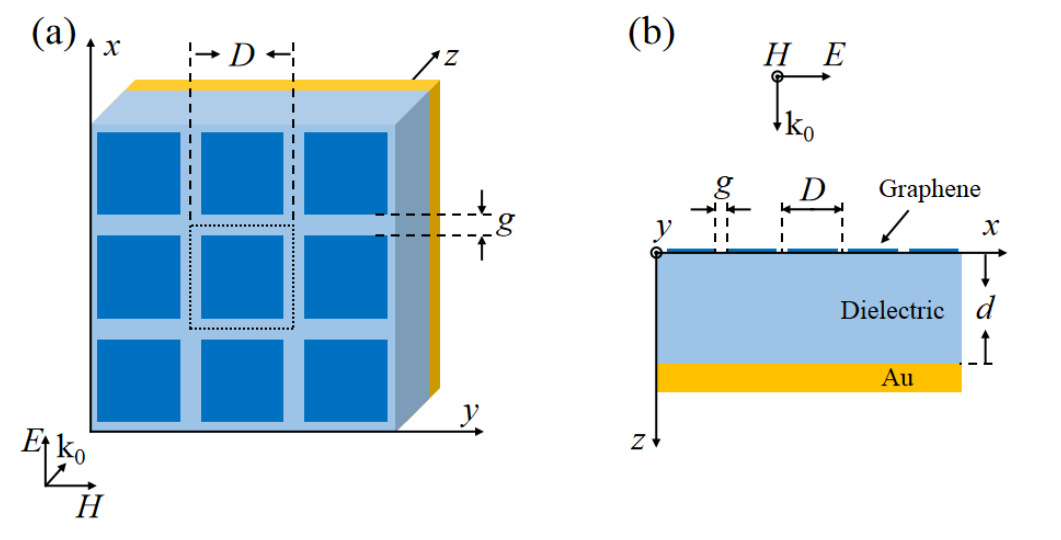
Figure 1. Schematic diagram of the proposed absorber: ( a ) perspective view. ( b ) side